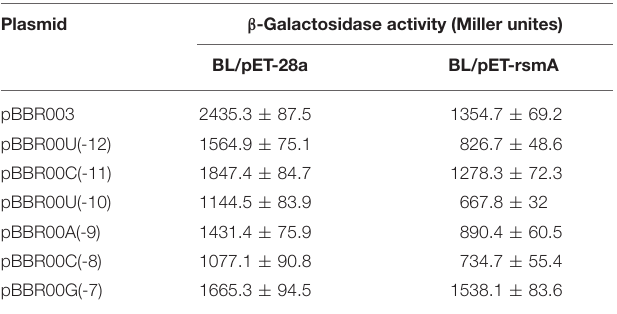
pET-28a. The effects of U(-12), C(-11), U(-10), A(-9), C(-8), G(-7) mutations on translational regulation by RsmA are in Table 3 . All mutations influenced regulatory control of RsmA.